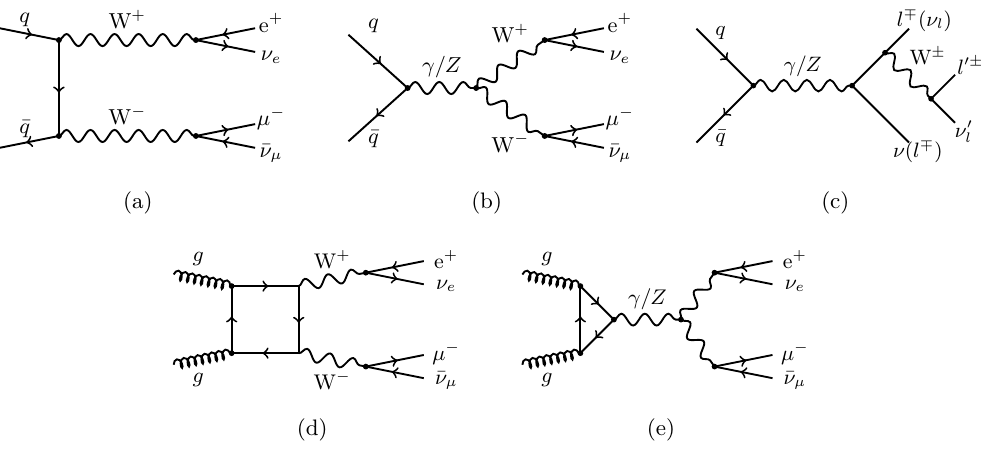
Figure 1 . Selected diagrams contributing to the pp → e + ν e µ − ¯ ν µ process. Diagrams (a,b) repre- sent Born double-resonant contribution; (c) — general case of Born single-resonant contributions (background); (d,e) — loop-induced double-resonant